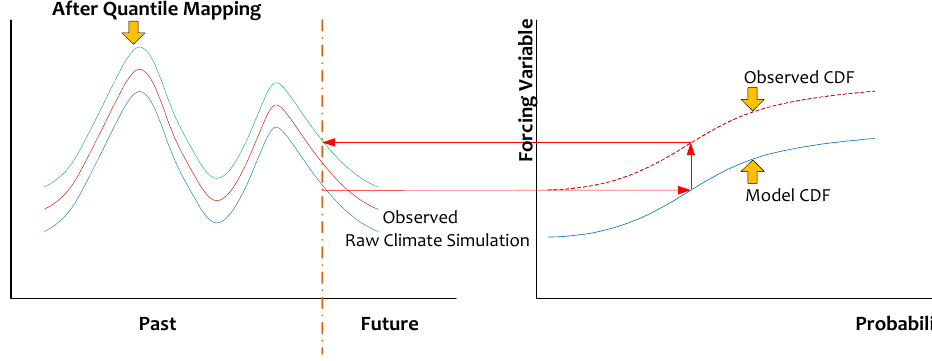
Figure 2. Quantile mapping for bias correction.